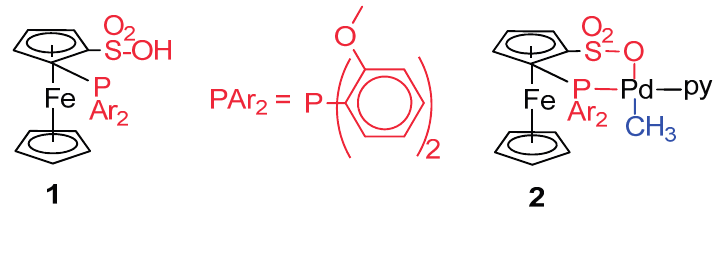
Figure 14. Diarylphosphinoferrocenesulfonic acid 1 for the synthesis of the catalyst precursor 2